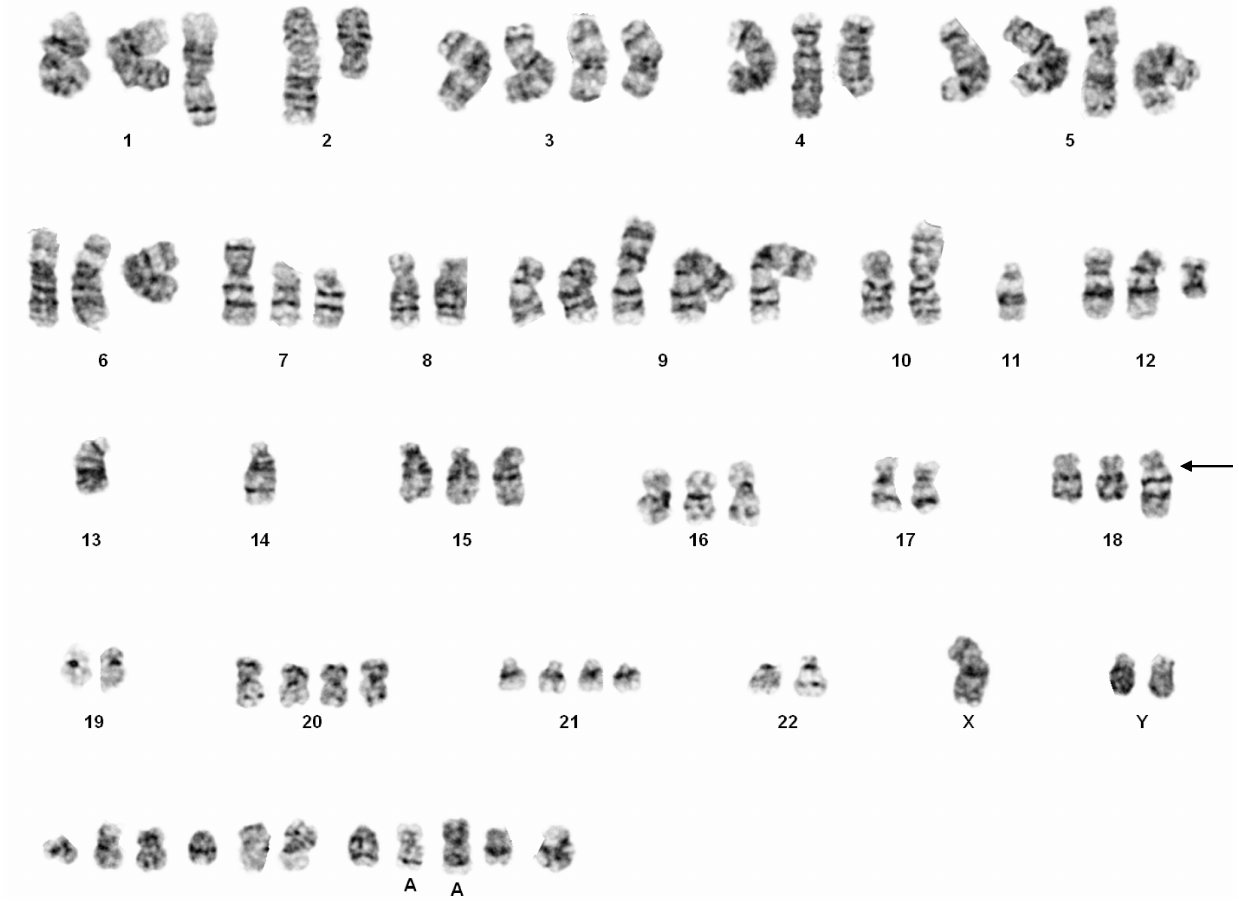
Figure 2. Karyogram of LX-2 cell. Representative numbers and appearance of chromosomes that was found in one LX-2 cell as obtained after Giemsa stain in lightmicroscopic analysis. The karyotype was determined to 74, XYY, + del(1)(q4?1), der(2;10)(p10;p10), + del(3)(q25)x2, + der(4)add(4)(q31), der(5)?t(5;9)(q35;q34)?del(5)(p15), der(5)add(5)(p1?3), + der(5)add(5)(p1?3)x2, + 6,del(7)(p1?3), + del(7)(p1?3), + der(9)(11q23- . 11q21::14q32- . 14q11.2::9p13- . 9qter)x3, + i(10)(q10), 2 11, del(11)(p11.2), + del(12)(pter- . q12::q15- . q22::q24.2- . qter), 2 13, 2 14, + 15, + der(16)t(16;17)(q11.1;q11.2), + der(18)(18pter- . 18q11.2::1q25- . 1q32::7q22- . 7qter), + 20, + 20, + 21, + 21, der(22)?t(22;?)(q11.2;?), + 11mar, respec- tively. Please note that a characteristic derivative of chromosome 18, i.e. + der(18)(18pter- . 18q11.2::1q25- . 1q32::7q22- . 7qter), is marked with an arrow in this figure. A characteristic derivative of chromosome 18 that contains part of chromosomes 1 and 7 was seen in three karyograms and is marked by a black arrow.